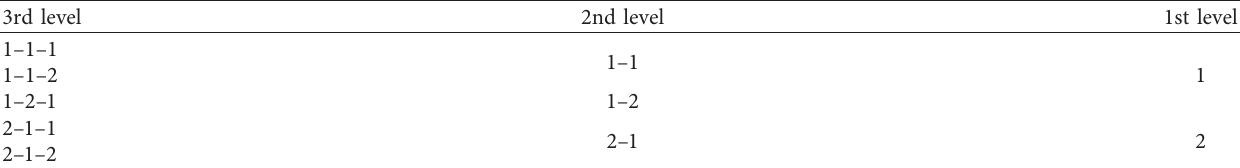
Table 1: The stratigraphical columns per level after coarsening.